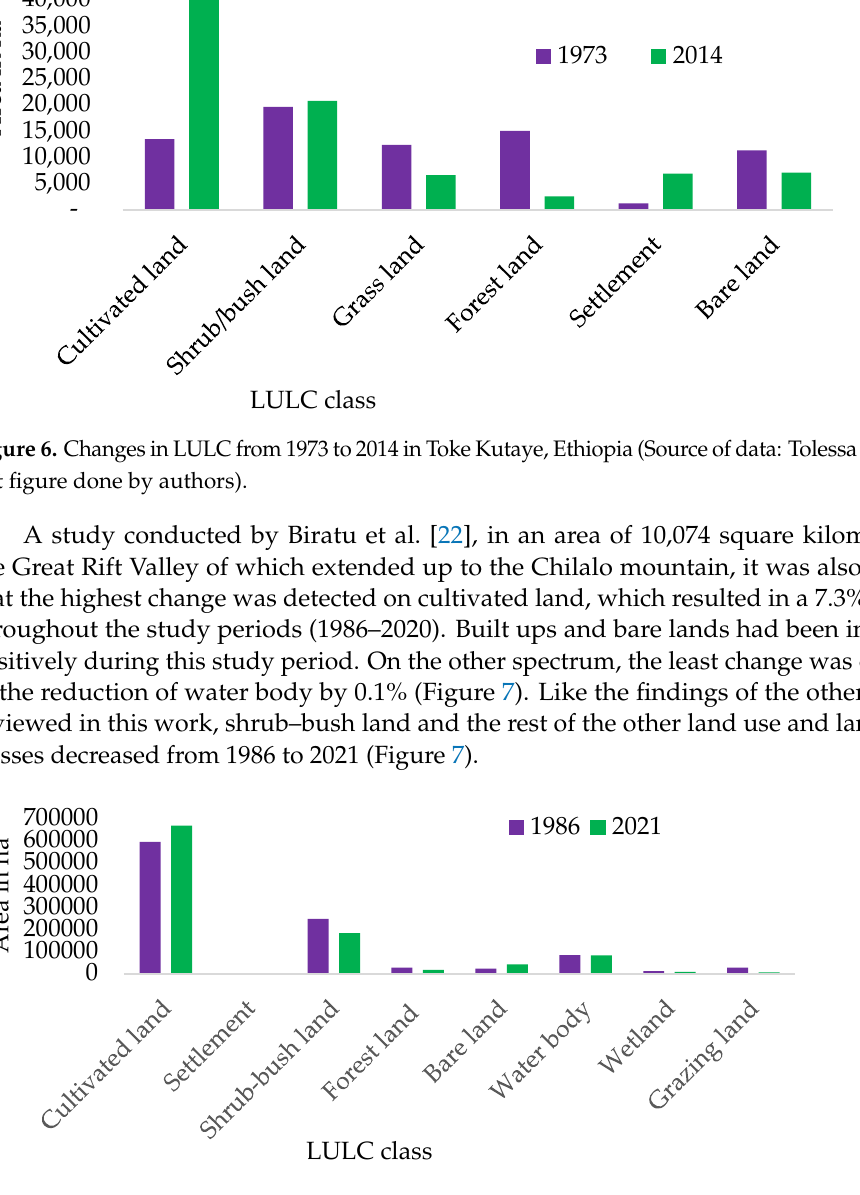
Figure 5. Changes in LULC from 1973 to 2012 in Munessa-Shashemene, Ethiopia (Source of data: Kindu et al. [1], but figure done by authors).